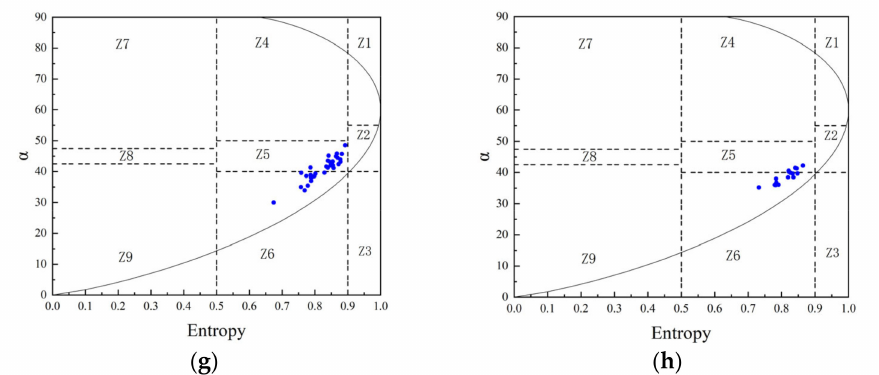
Figure 4. H and α plots of the wheat fields on sampling dates. ( a ) 9 May 2019, ( b ) 16 May 2019,